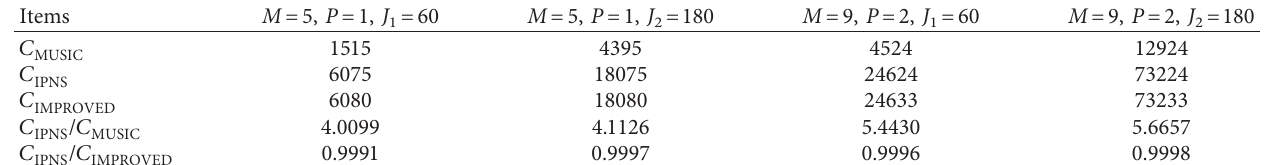
Table 1: Comparison of the computational complexities of different methods.